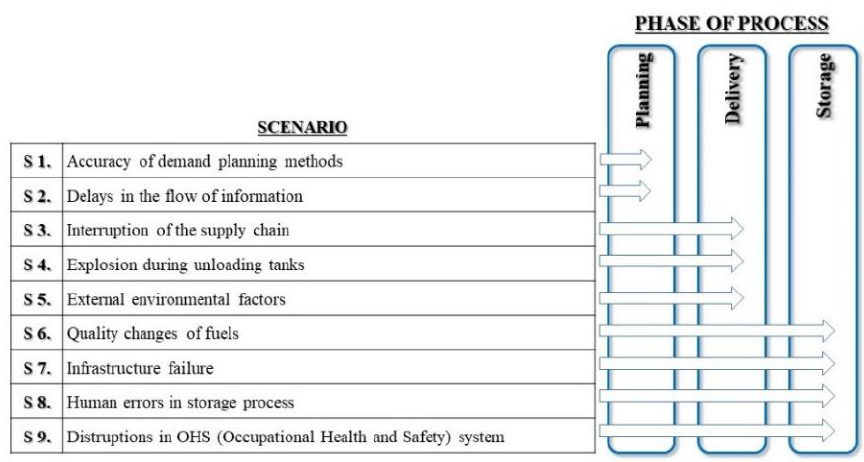
Figure 3. Relationship: Analysed scenario—phase of the supply process.